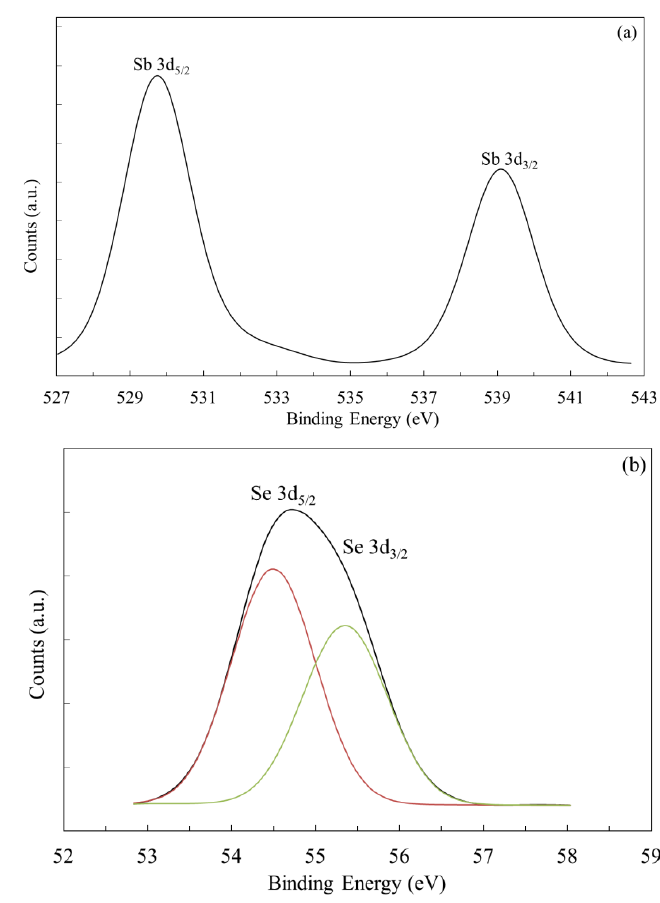
Figure 6. XPS profile of ( a ) Sb ( b ) Se.